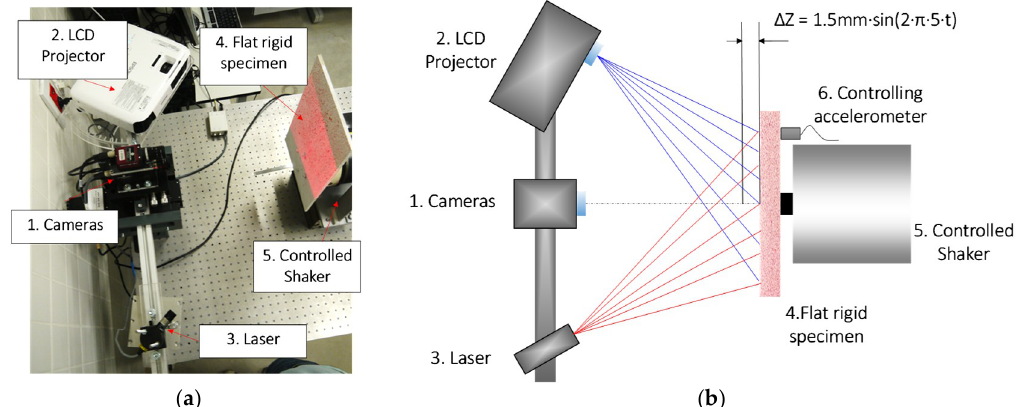
Figure 7 . Set-up employed in vibration test. ( a ) Actual set-up; ( b ) schematic distribution.